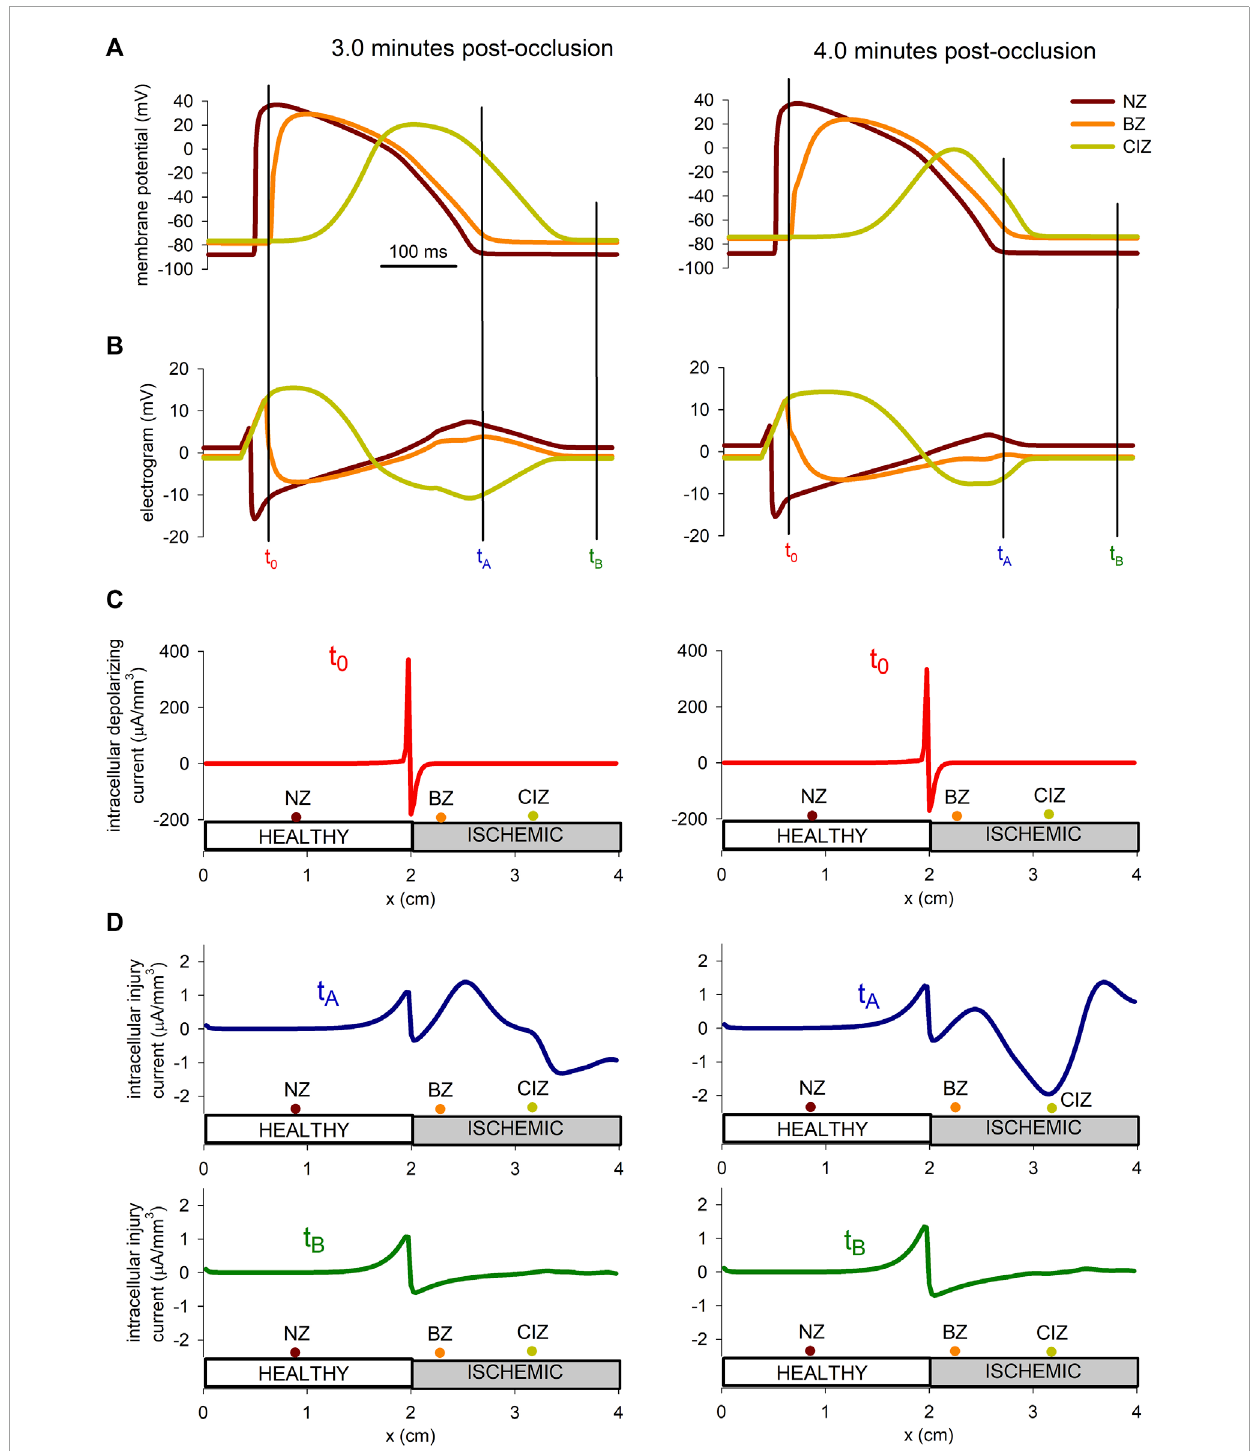
FIGURE 9 Injury current during acute regional ischemia. (A) : Action potentials at three different locations within the cable at two instances after the onset of ischemia. (B) : Simulated electrograms at the same positions and time instants as in panel (B) . (C) Intracellular depolarizing current at the moment the depolarizing front enters the ischemic region. (D) Intracellular injury current at the moment of deepest negative T-wave in the ischemic zone and during the diastolic